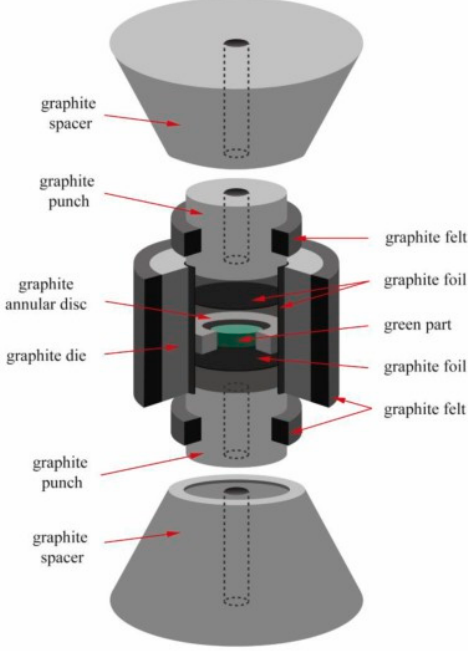
Figure 10. Schematic illustration of the experimental assembly of the graphite tools used for pressureless-SPS. Reproduced with permission from reference [70].